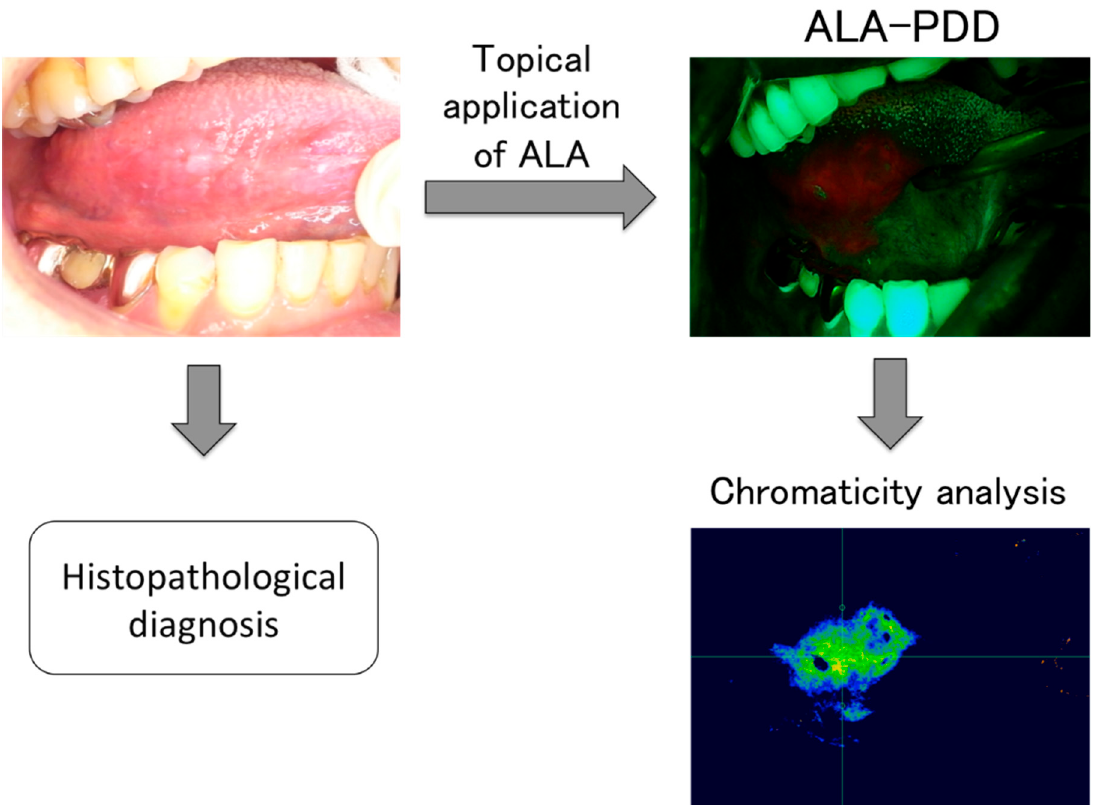
Figure 2. Observations of the oral cavity included the following steps: topical application of the ALA solution, observation using the PDD system, and histopathological diagnosis. Subsequently, the C R : chromaticity x (red) on the lesion sites was measured from the fluorescence images using Eye-Scale one software (I-system, Tokyo, Japan). The example shows a case with slight erosion of the tongue, which was diagnosed histopathologically as moderate oral epithelial dysplasia (OED). Images were converted by the software to measure C R .